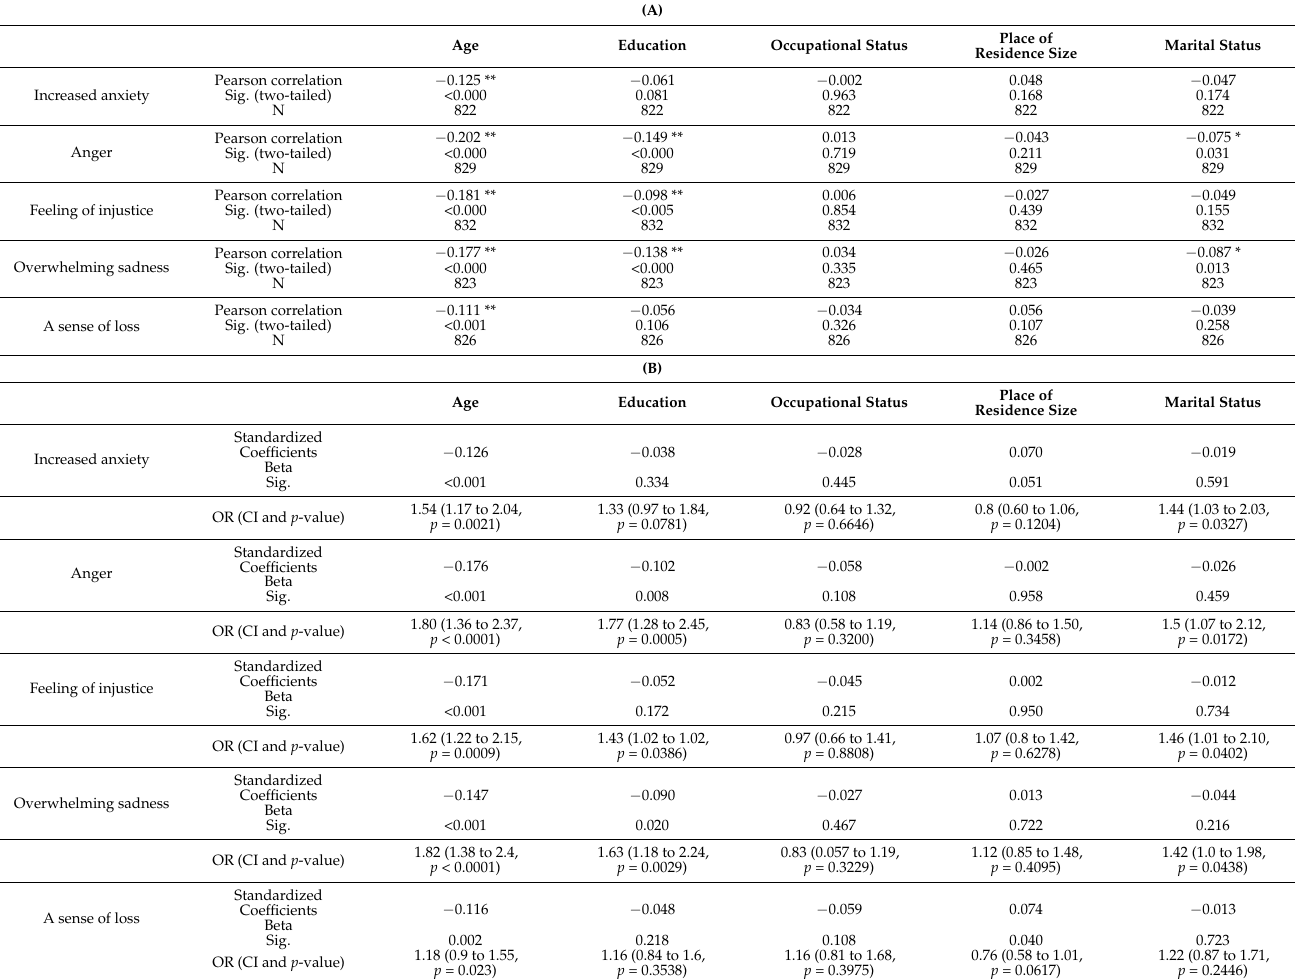
Table 2. ( A ) Pearson correlation between demographic variables and perceived emotions related to separation. ( B ) Multivariate linear regression analysis and odds